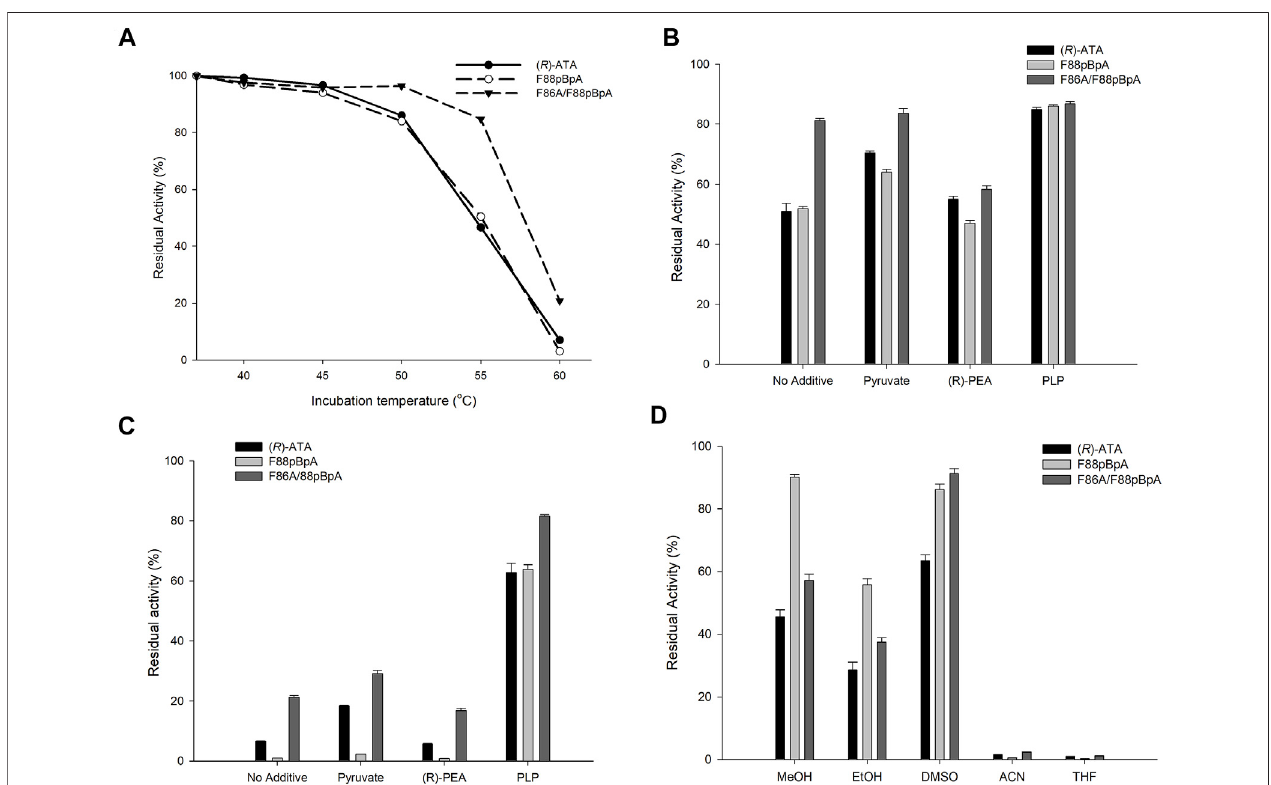
FIGURE 5 | (A) The residual activity of ( R )-ATA and its variants at 37 – 60 ° C without any additive. The residual activity of ( R )-ATA and its variants in the presence of pyruvate, 1a, and PLP at (B) 55 ° C, and (C) 60 ° C. (D) The residual activity of ( R )-ATA and its variants in the presence of different organic solvents (20%